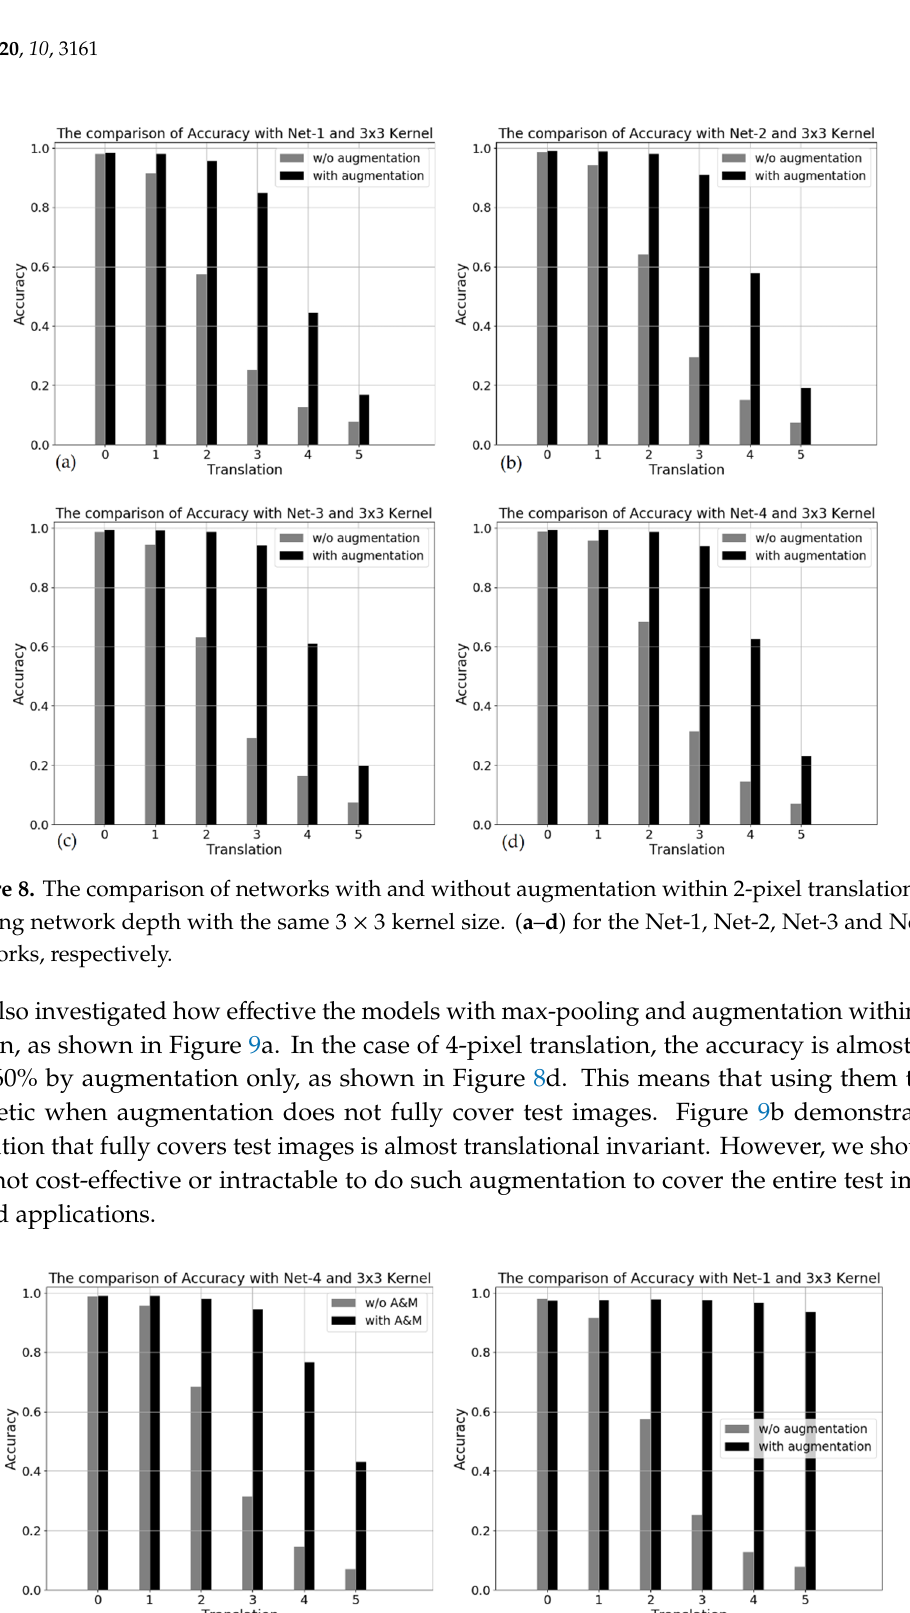
Figure 7. The comparison of networks with and without max-pooling by varying network depth with the same 3 × 3 kernel size. ( a – d ) for the Net-1, Net-2, Net-3 and Net-4 networks, respectively.